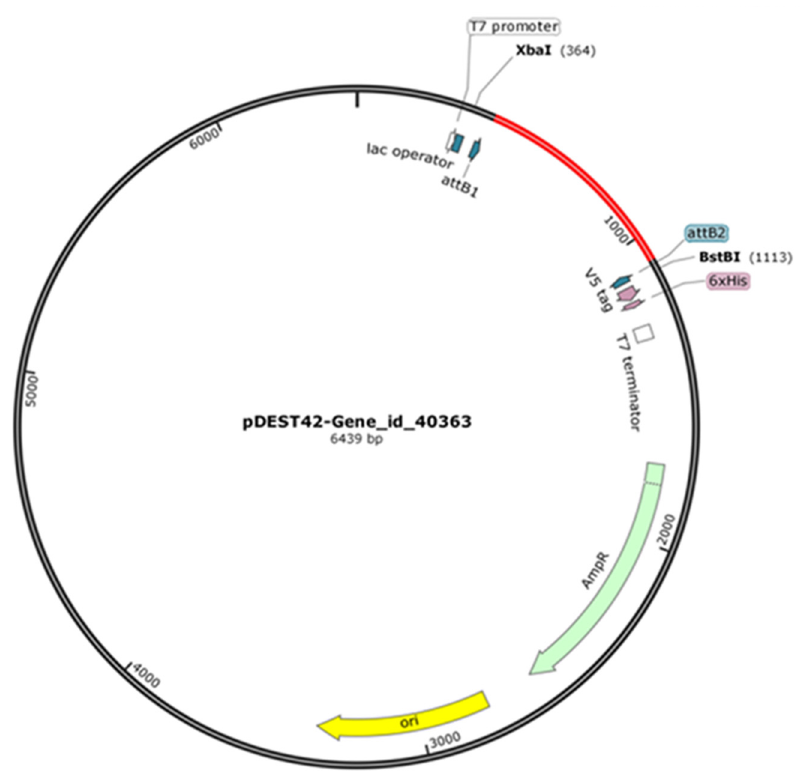
Figure 8. Expression vector construct. The expression plasmid with Gene_id_40363 ligated was modelled in SnapGene (Dotmatics San Diego, USA). Position of gene insert is indicated by the red segment, and selected plasmid features are also annotated.